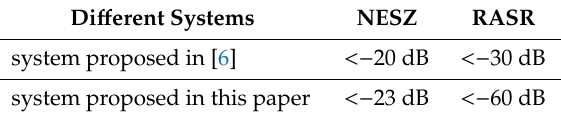
Table 5. Comparison of the